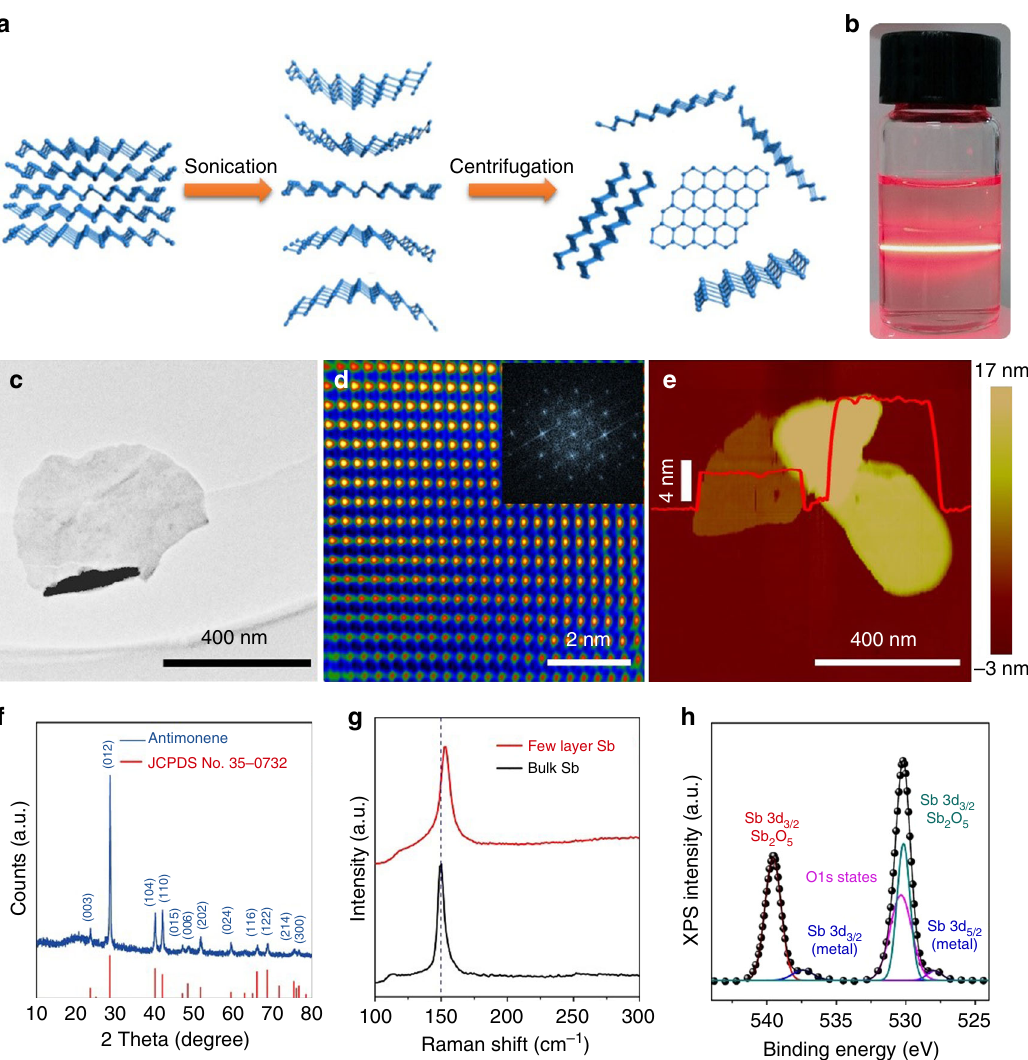
Fig. 3 Fabrication and characterization of antimonene materials. a A schematic representation of the preparation process of two-dimensional antimonene. b Photograph of a dispersion of exfoliated antimonene showing the Faraday – Tyndall effect. c , d TEM (scale bar = 400 nm) and FFT-masked HRTEM images (scale bar = 2 nm) of few-layer antimonene after exfoliation. e AFM topography showing few-layer antimonene on mica (scale bar = 400nm). f XRD spectrum of antimonene (blue line). g Raman spectra of bulk antimony with β -phase (black line) and few-layer antimonene (blue line). The two peaks represent two different vibrational modes. h XPS spectra of Sb 3